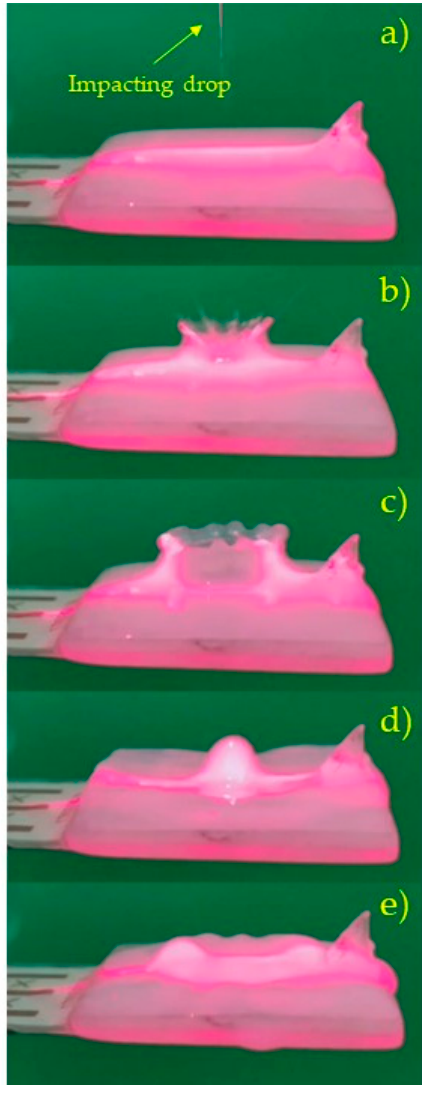
Figure 16. Sequence of four pictures of the spoon full of water taken just after the impact of a raindrop.